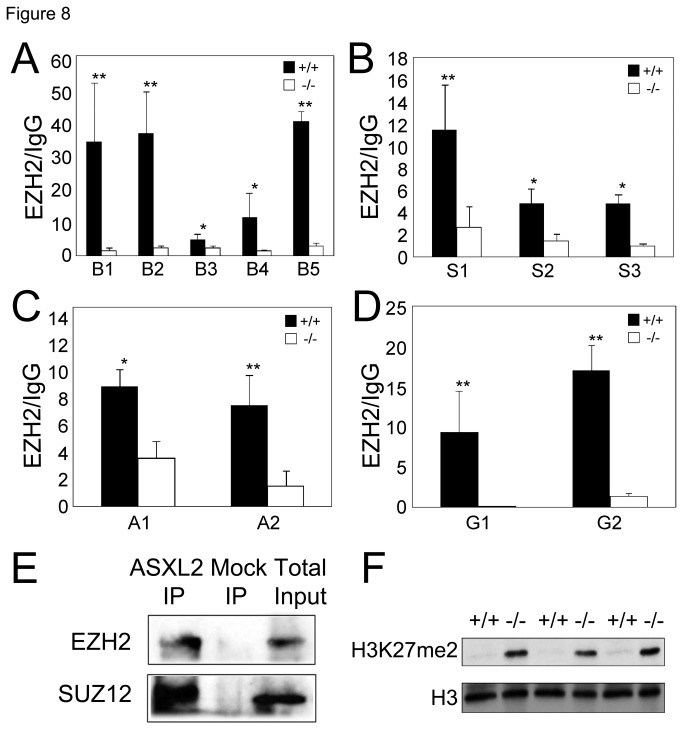
ASXL2 interacts with PRC2 and is required for PRC2 enrichment at select target genes in the mouse heart.The level of EZH2 enrichment at β-MHC (A), Sfrp2 (B), Acta1 (C) and Grk5 (D) in wild-type and Asxl2
-/- hearts was compared by ChIP-qPCR. Data from EZH2 ChIP were normalized against those from IgG mock ChIP. Each column represents the mean value of data from three independent samples. *p<0.05; **p<0.01; Error bar: standard deviation. (E) Co-IP analysis of the interaction between ASXL2 and PRC2 components. Wild-type heart extract was IPed using KC17 anti-ASXL2 antibody. Mock IP was performed with pre-immune rabbit serum. IPed samples were analyzed by Western blot using anti-EZH2 and anti-SUZ12. (F) Western blot analysis of bulk H3K27me2 in three pairs of wild-type and Asxl2
-/- hearts. To control for comparable protein loading, the blot was stripped and re-blotted for histone H3.